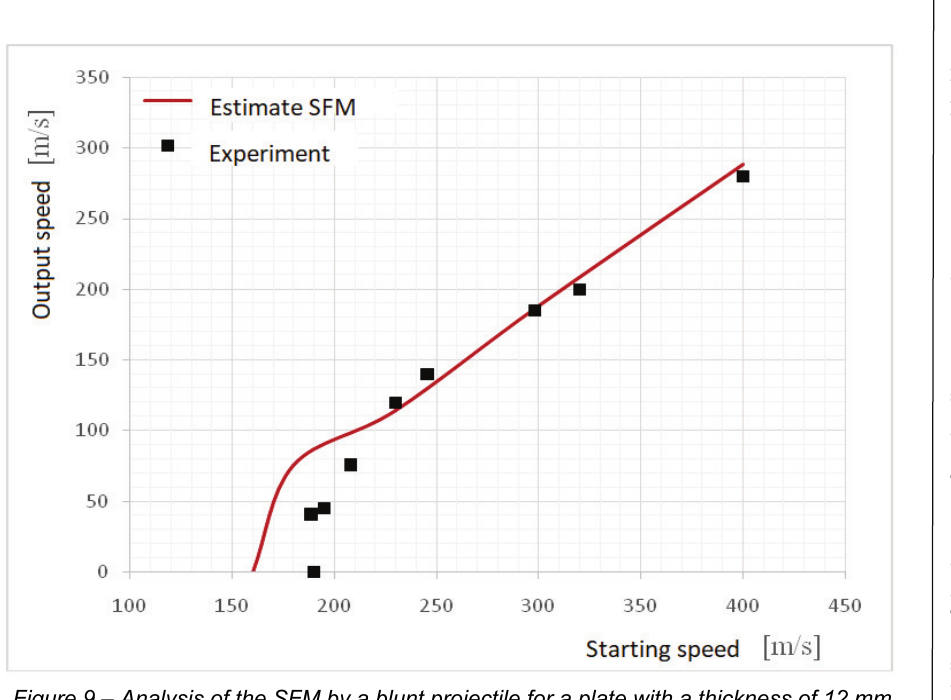
Figure 9 – Analysis of the SFM by a blunt projectile for a plate with a thickness of 12 mm Рис . 9 – Анализ SFM тупоконечным снарядом на плиту , толщиной 12 мм